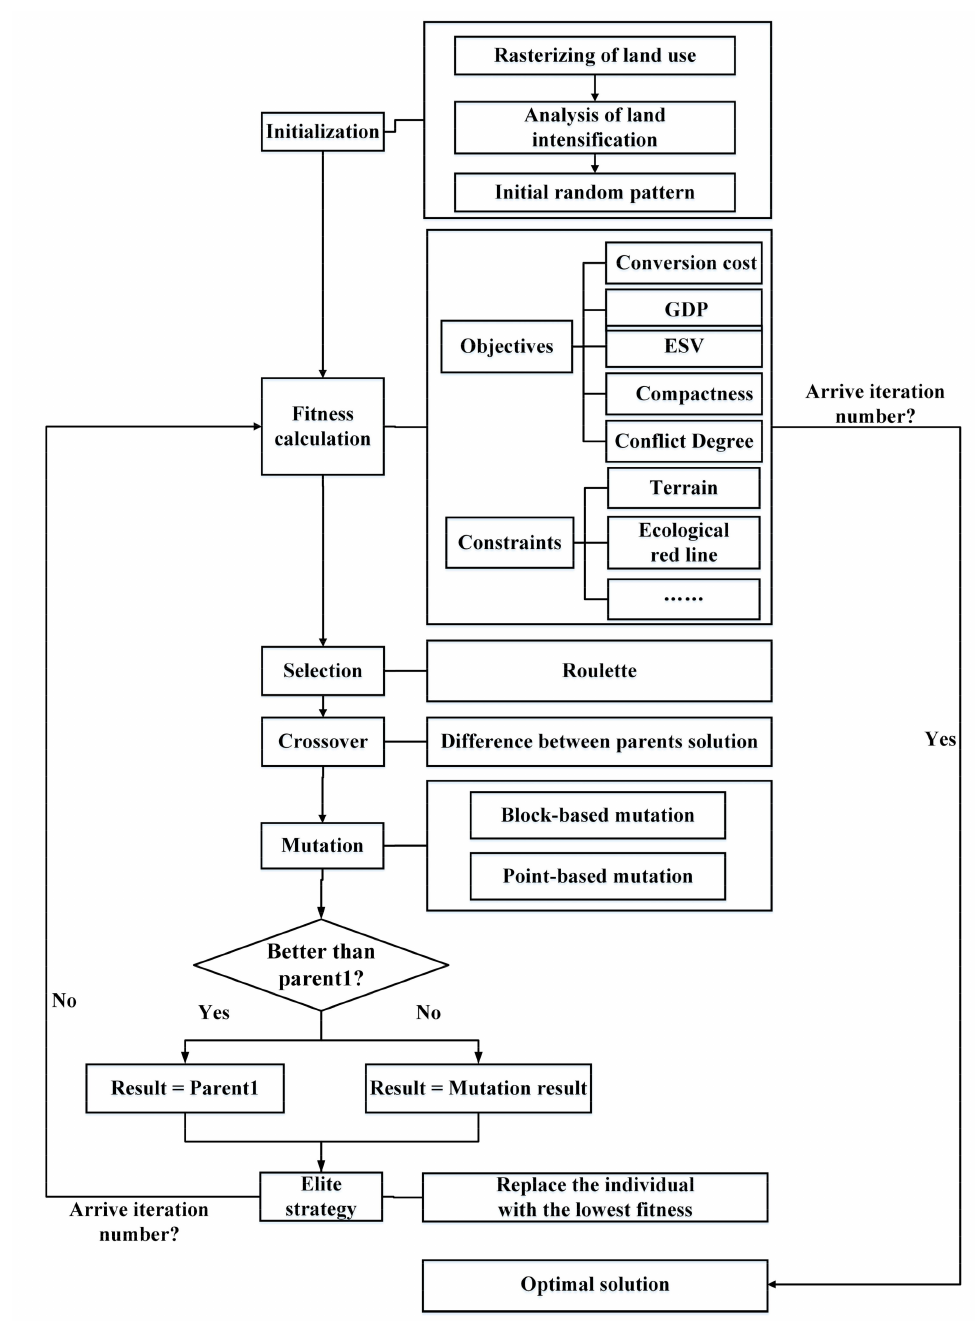
Figure 2. Workflow procedure of the Land use Intensity-restricted Multi-objective Spatial Opti- mization (LIr-MSO) model for iteratively deriving the fittest optimal land-use pattern from an initial